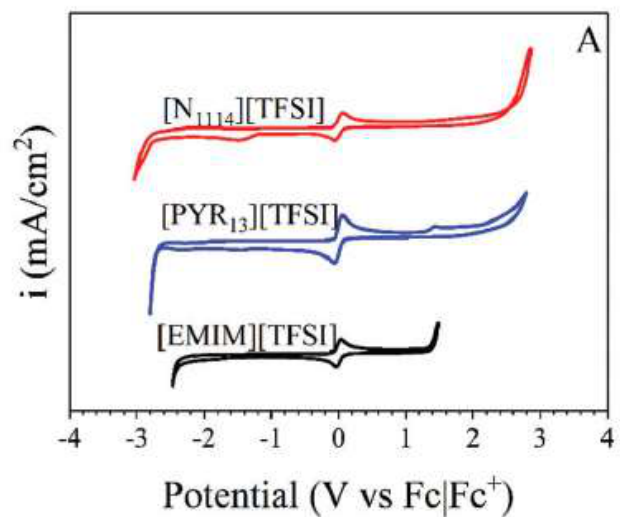
Figure 19. Cyclic voltammograms of [emim][NTf 2 ], [N 1114 ][NTf 2 ], and [Pyr 13 ][NTf 2 ] with 10 mM ferrocene (Fc). Scan rate = 20 mV/s. Reproduced with permission from [77], copyright 2018, RSC.